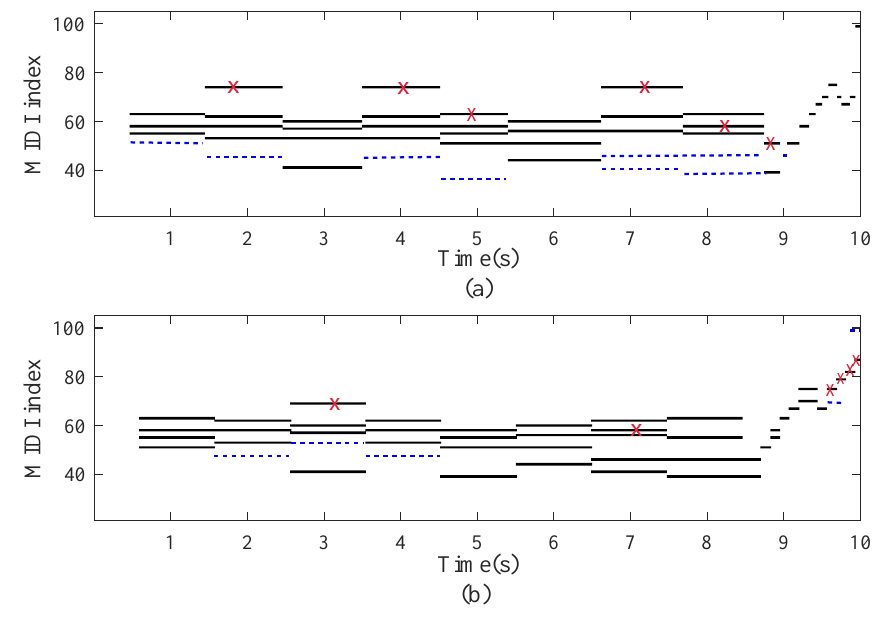
Figure 8. Results of piano transcription: ( a ) the transcription produced by CNNs in our proposed framwork; and ( b ) the transcription produced by Troxel’s